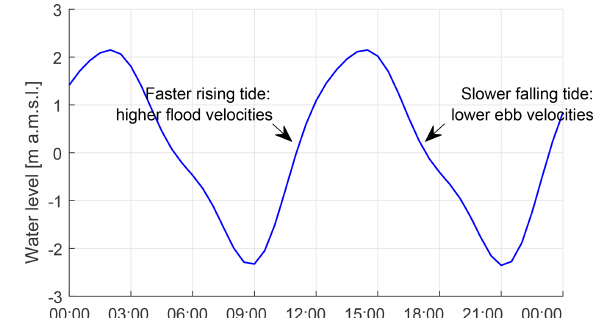
Figure 5. Tidal signal recorded at the Guayaquil gauging station.